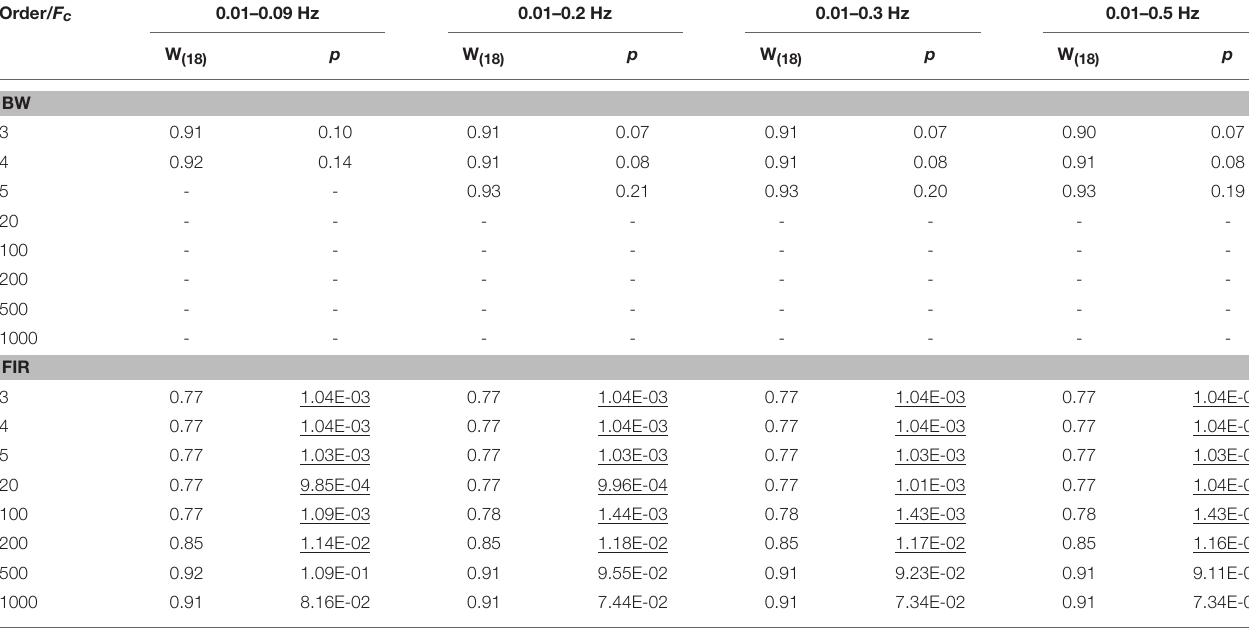
W-values and corresponding p-values are reported. p < 0.05 are underlined, meaning that the null hypothesis that the β -values are normally distributed is rejected at significance level α = 0.05. Results are not reported in case of unstable filters. ‘-’ indicates unstable filters for which the Shapiro-Wilk test was not carried out.